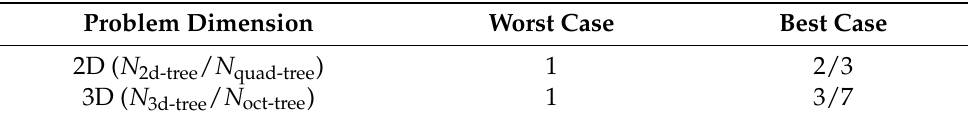
Table 1. Worst-case and best-case ratios of the number of sub-cells generated by kd-tree, quad-tree, and